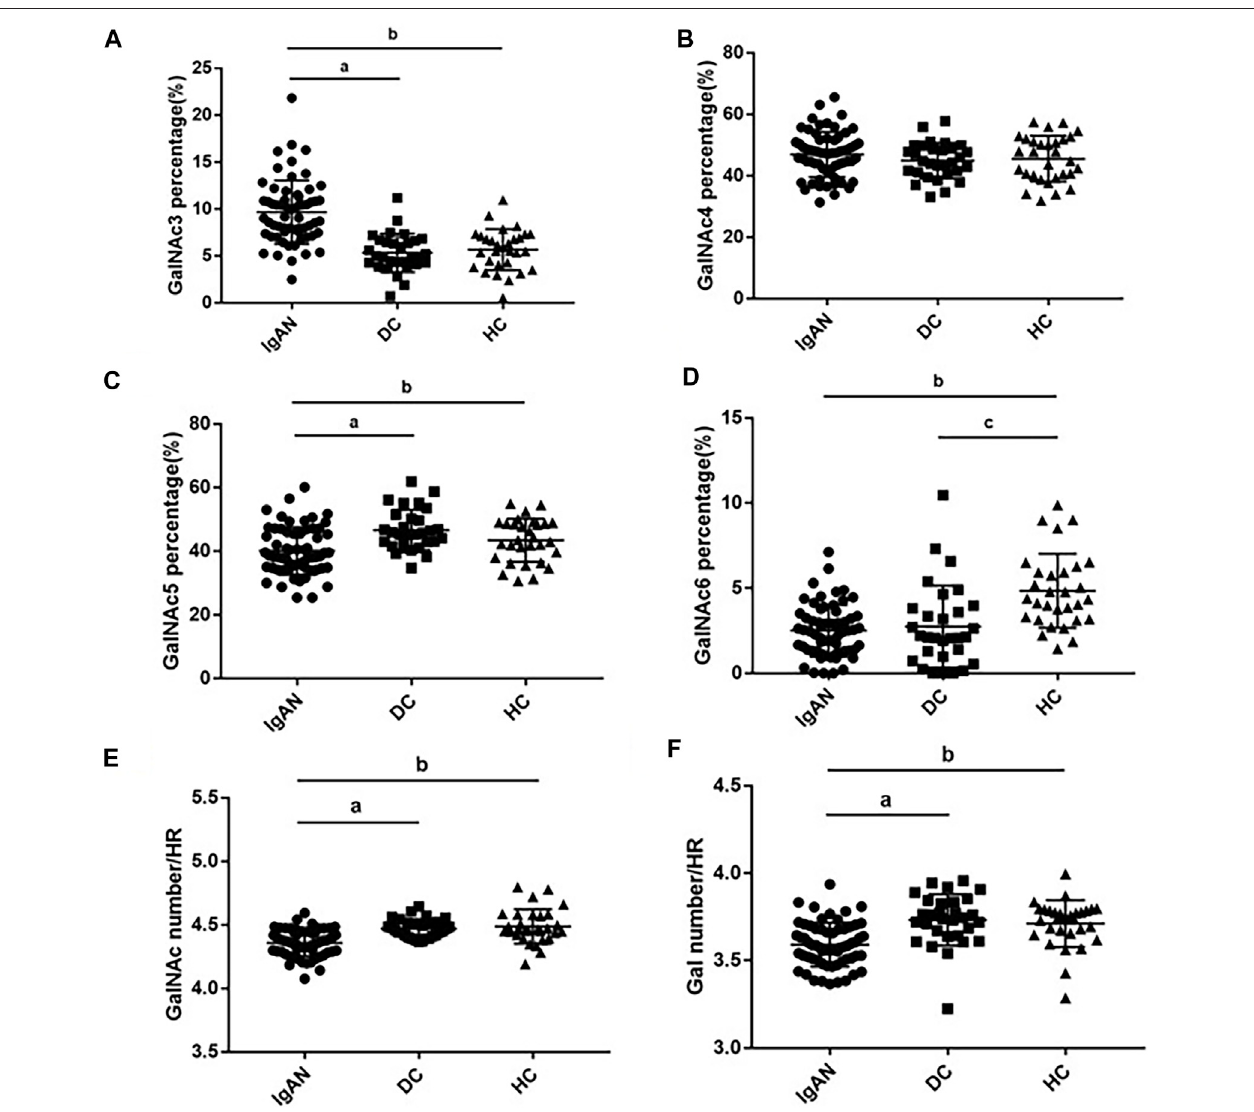
FIGURE5| Glycosylation traits in plasmaIgA1 HRamong thethree groups. Comparison ofGalNAc3-6 ratios inplasmaIgA1 HRamongIgAN, DCand HC groups (A – D) . Comparison of Gal and GalNAc numbers in plasma IgA1 HR among IgAN, DC and HC groups (E,F) . p a < 0.05: IgAN vs. DC; p b < 0.05: IgAN vs. HC; p c < 0.05: DC vs.